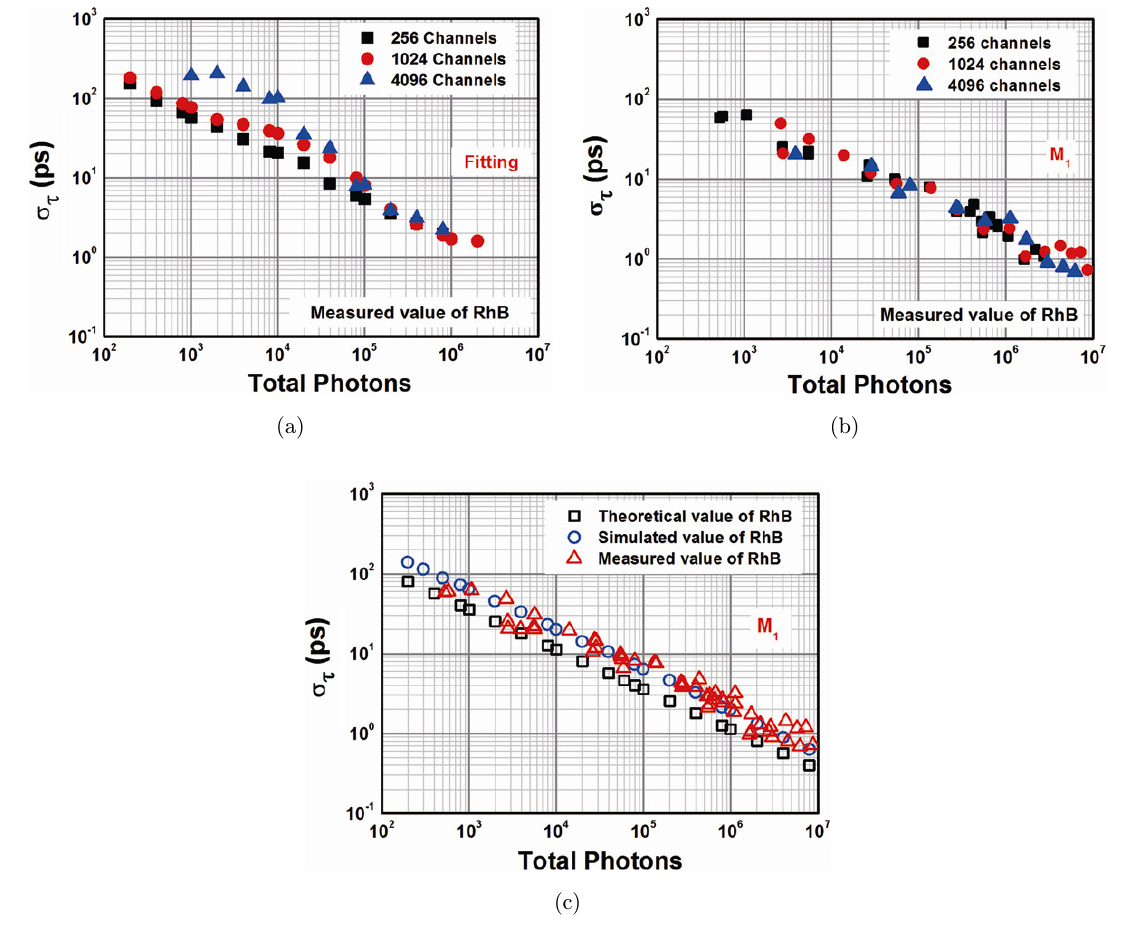
Fig. 4. The dependence between lifetime precision and signal